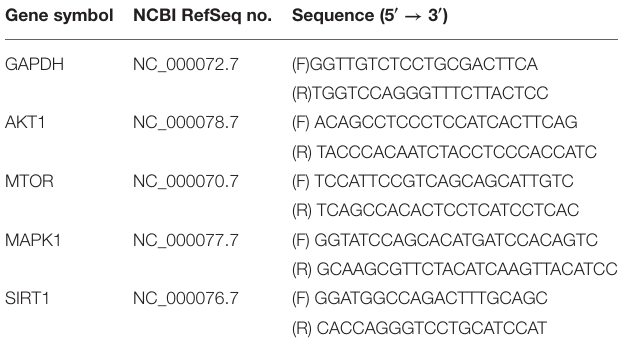
TABLE 1 | Primers used for qRT-PCR. Gene symbol NCBI RefSeq no. Sequence (5 ′ → 3 ′ ) GAPDH